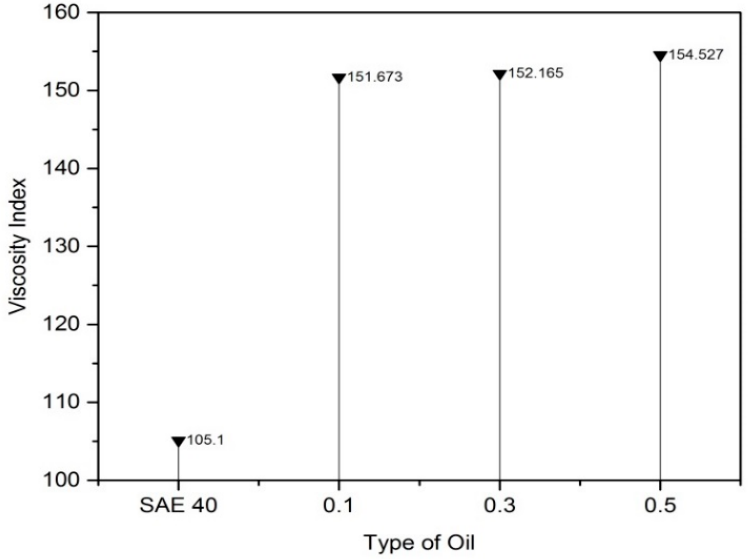
Figure 13. Viscosity index of SAE 40 and different concentrations.